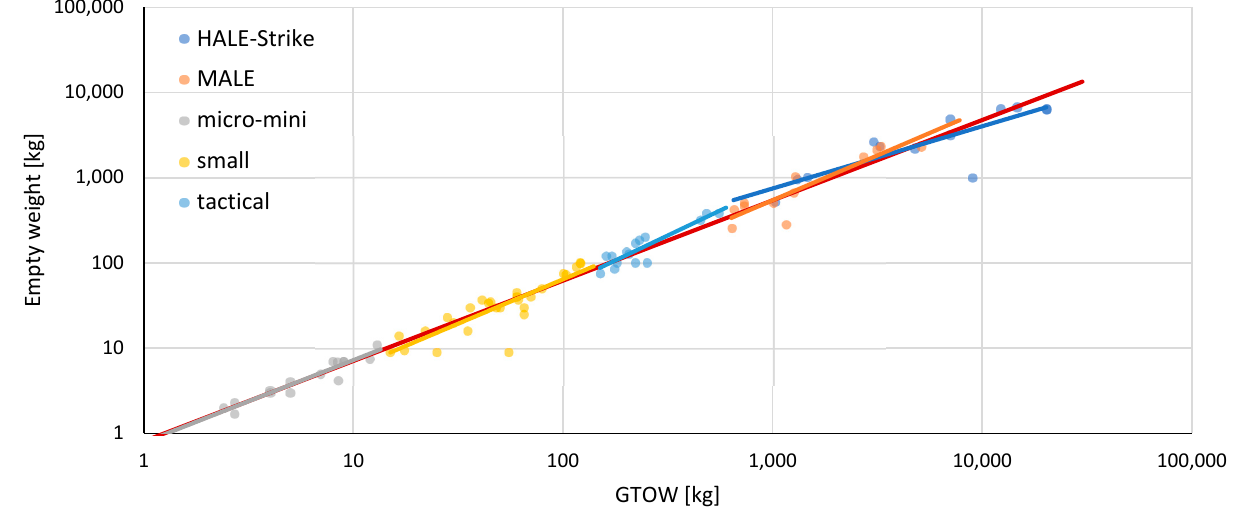
Figure 11. Empty weight as a function of GTOW for the general category.